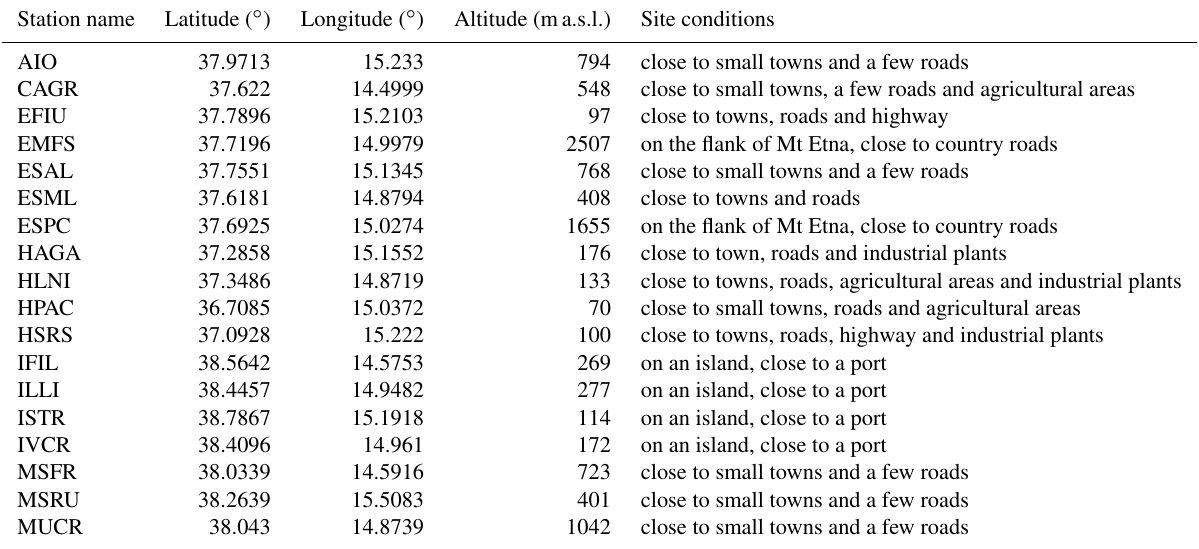
Table 1. List of the seismic stations used in this work, with information about location and site conditions in terms of possible sources of anthropogenic seismic